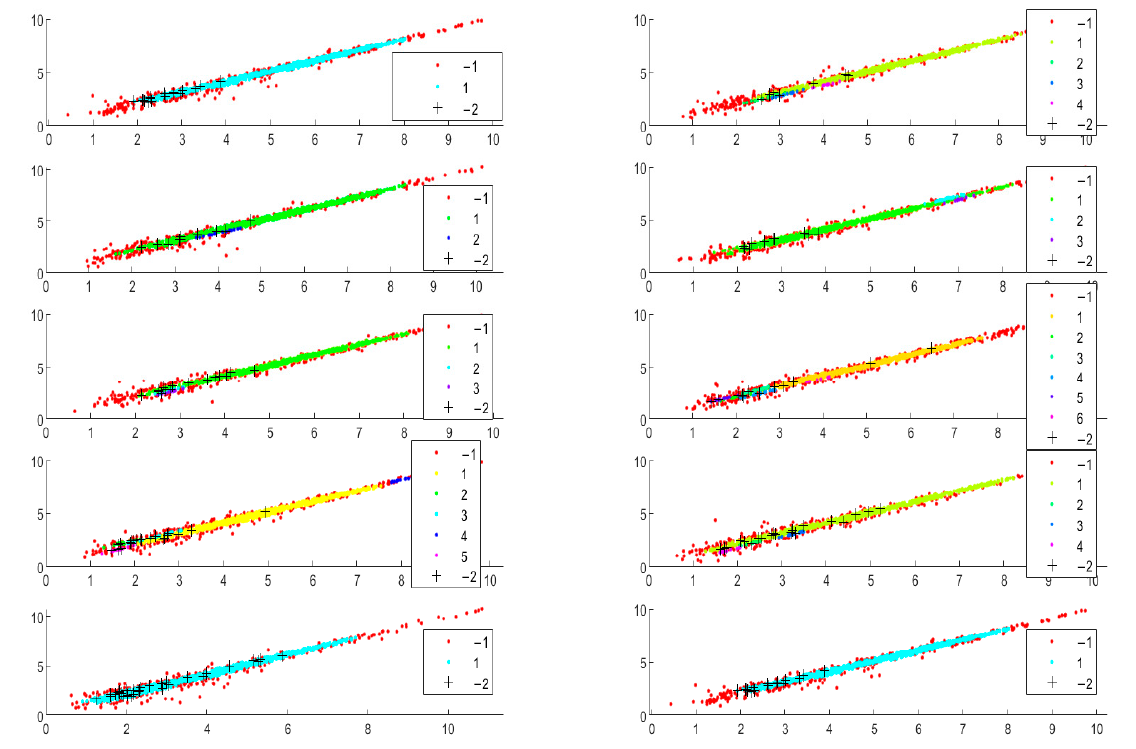
Figure 4. Scatter plots of iterative clustering results via Mahalonobis distance; batch size = 1022, r = 0.2, Nmin = 10.